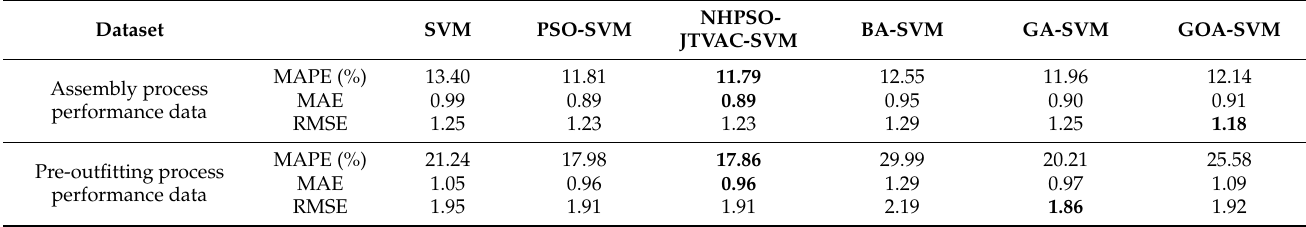
Table 7. Test errors of each